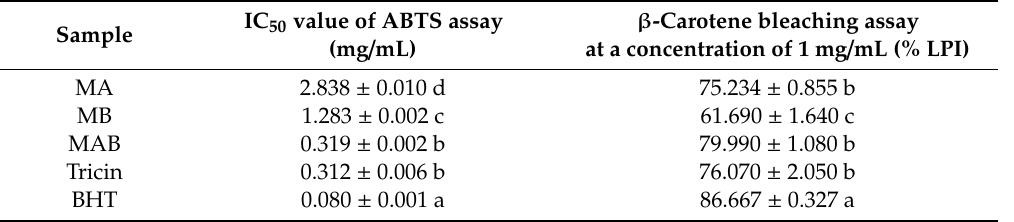
Table 2. Antioxidant activities of momilactones A, B, and tricin in terms of 2,2’-azino-bis (ABTS) and